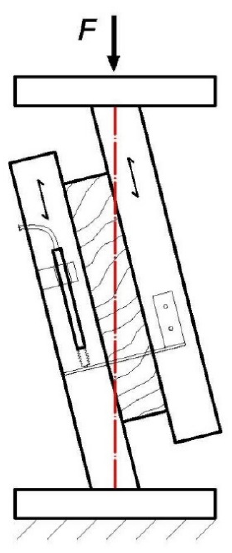
Figure 3. Schematic of the test setup.